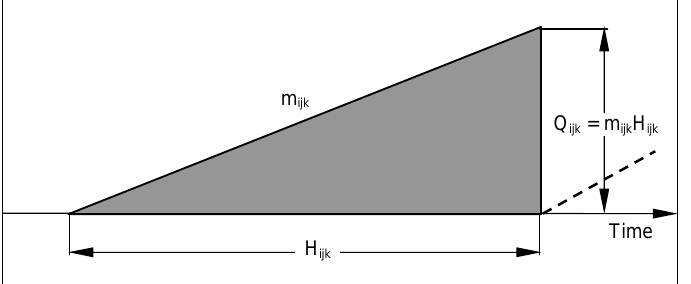
Figure 4. A scheme of the inventories of goods (k) at the manufacturer (i) before being sent to the consumer